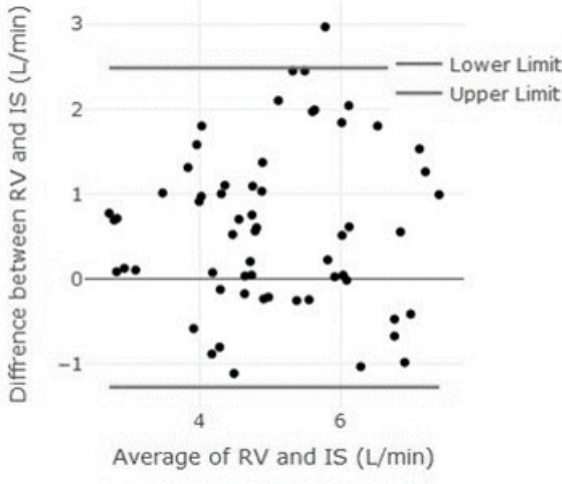
Figure 1: Limit of agreement of the two measurements of the